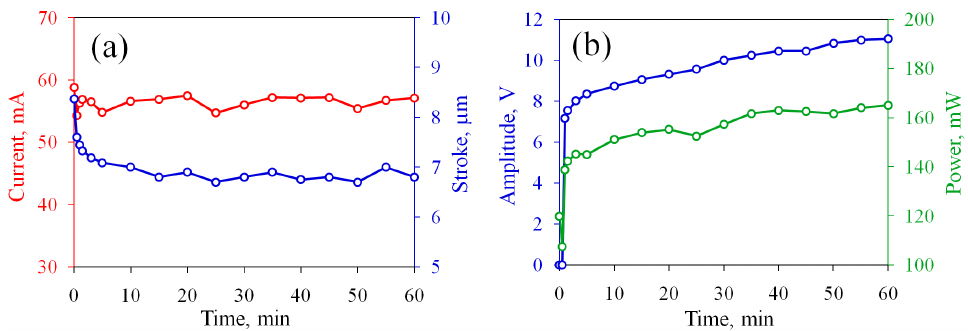
Figure 7. The actuator with non-oxidized electrodes in the current stabilization regime: ( a ) time dependence of the current and stroke; ( b ) the same for the amplitude of the SP pulses and consumed